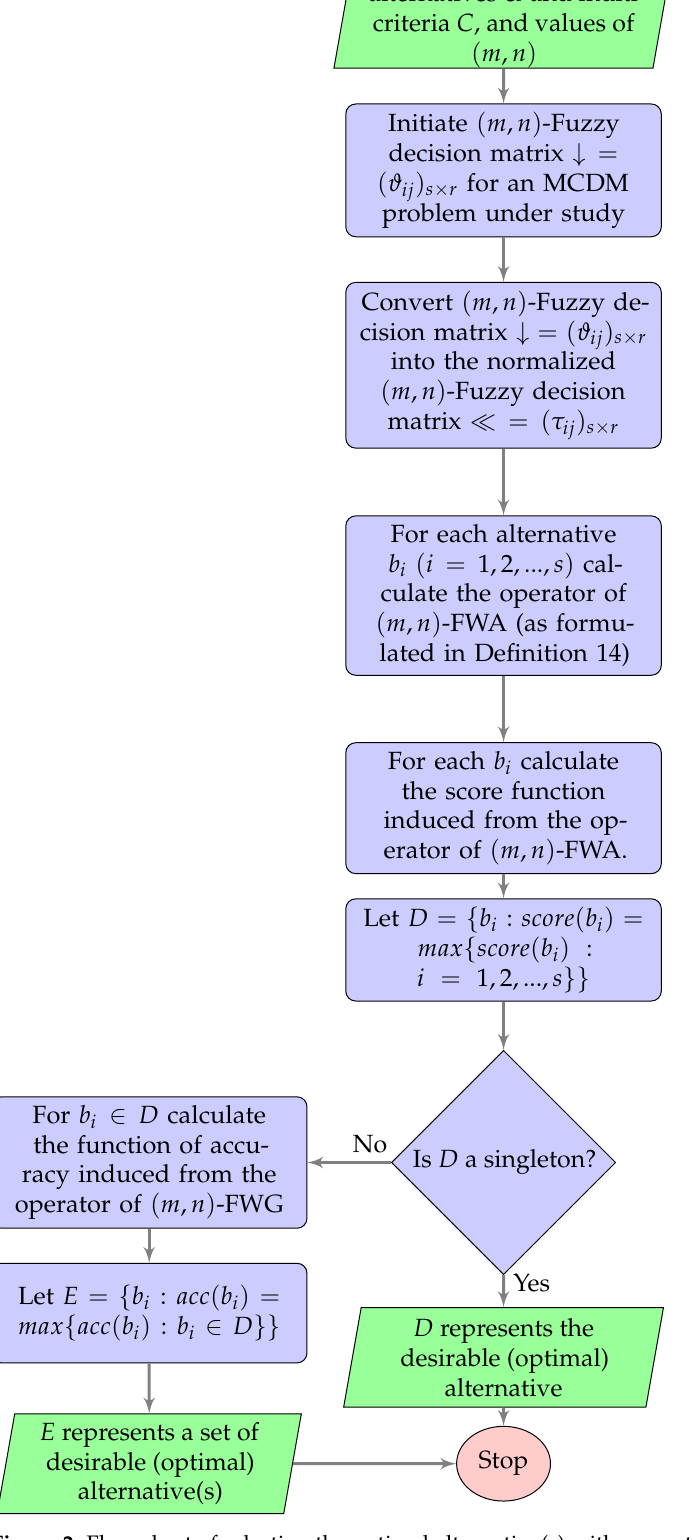
Figure 2. Flow chart of selection the optimal alternative(s) with respect to ( m , n ) -FWA